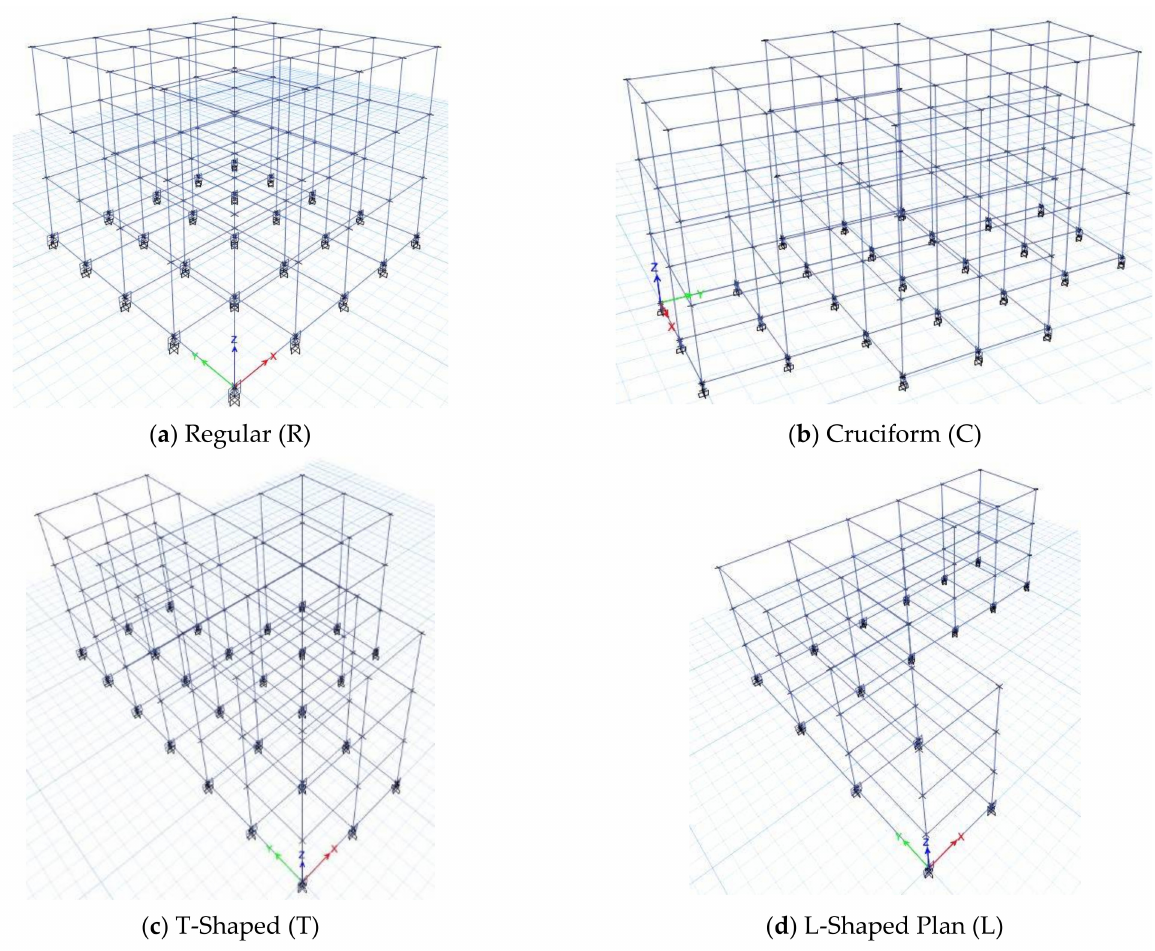
Figure 4. Three-dimensional views of the